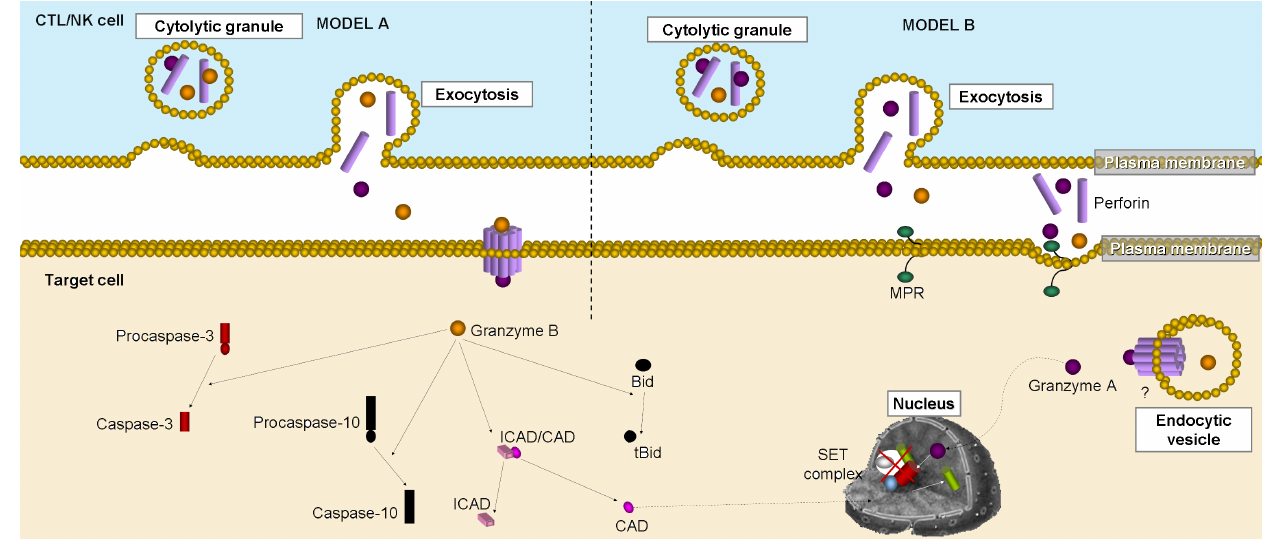
Figure 4. Perforin/granzyme-mediated apoptotic cell death. Despite specific cytotoxic T lymphocytes (CTL) and natural killers (NK), this type of apoptosis is essential for the defensive role of our immune system. Model A and Model B represent proposed strategies for granzyme introduction in the target cell. Perforin is required for the granzyme-mediated apoptotic death of the target cell but it is no clear whether it directly forms pores in the plasma membrane of the target cell (Model A) or whether perforin/granzyme internalization occurs via receptor-mediated endocytosis (Model B). Mannosa-6-phosphate receptor